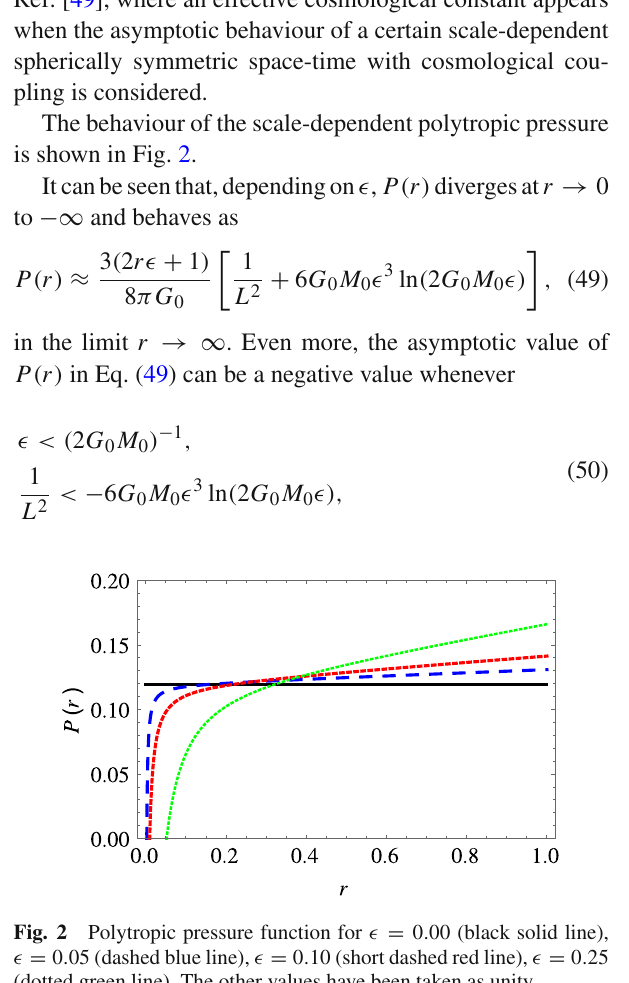
which coincides with the condition demanded for a de Sitter asymptotic behaviour of f ( r ) in Eq.